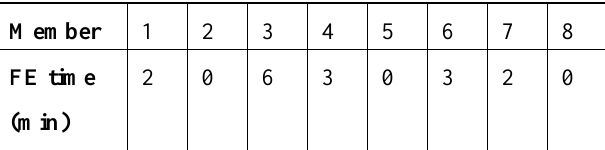
Table 3. Sample Data to Illustrate Parallel Schemes